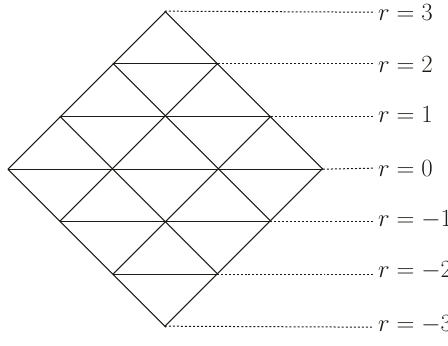
Figure 3 . Limiting Hodge diamond displaying the r j levels in which generic d -forms live in the singularity. For definiteness, we have particularized here to the case d = 3